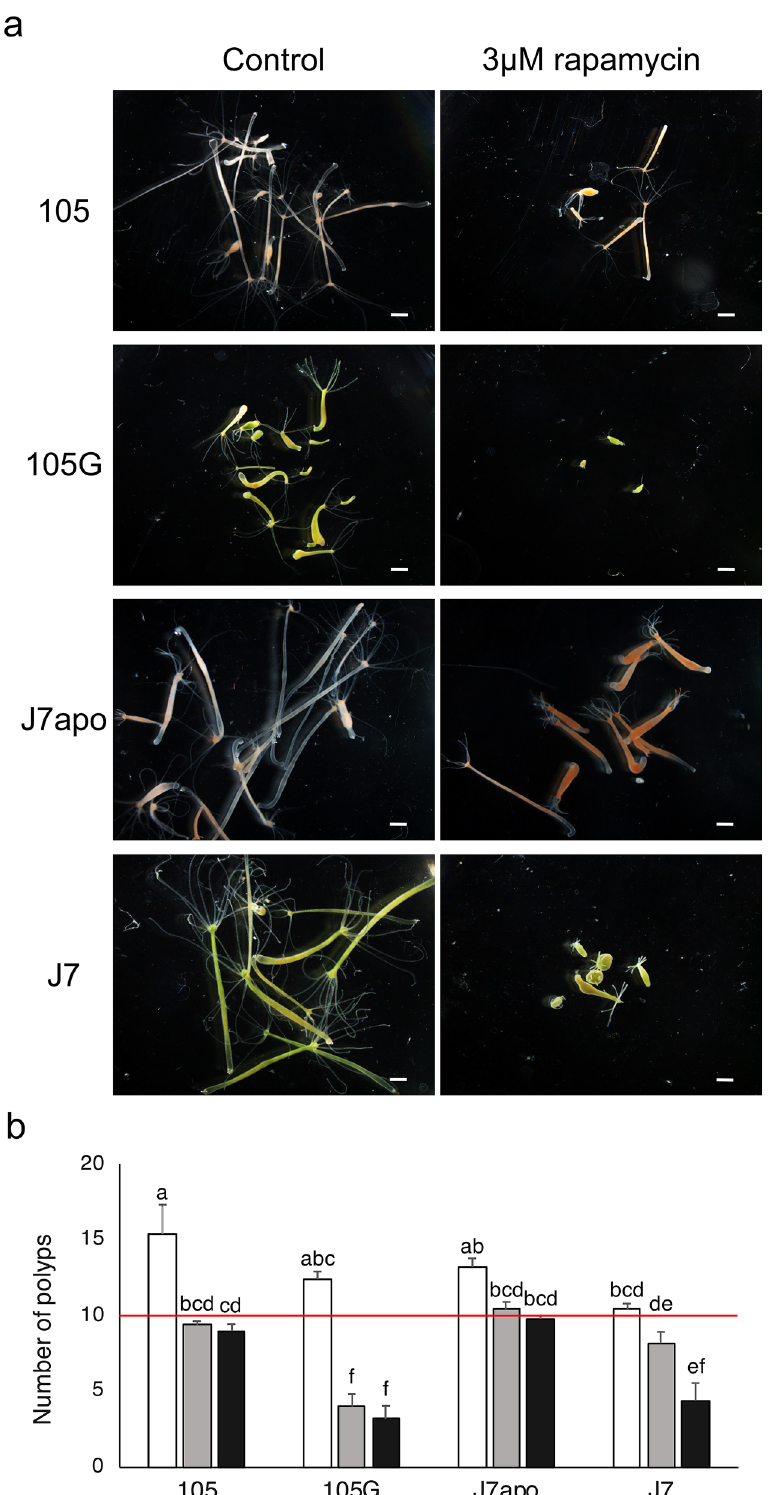
Figure 3. Effect of translation inhibition with rapamycin treatment. ( a ) The polyp condition 2 weeks after the start of rapamycin treatment. The symbiotic polyps (strain 105G, J7) shrank in 3 μM rapamycin. Scale bars: 1 mm. ( b ) The number of polyps two weeks after the start of rapamycin treatment. The error bars show the standard error in each condition. The red line represents the number of polyps (n = 10) at the start of the treatment. The significant differences were calculated by Tukey’s test among each condition (P < 0.05). The same letters between the bars represent no significant